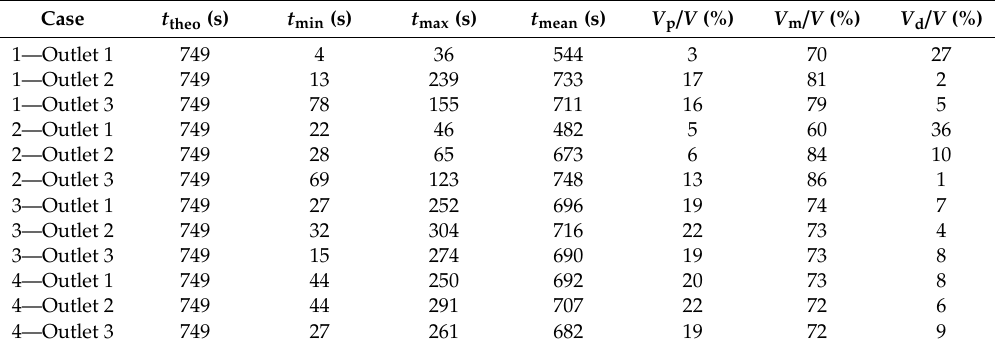
Figure 10. E-curves of the numeric and experimental model. ( a ) Case 1—bare; ( b ) Case 2—TI; ( c ) Case 3—UB; ( d ) Case 4—UB + TI. Table 4. Computational RTD parameters and the volume fraction of flow.